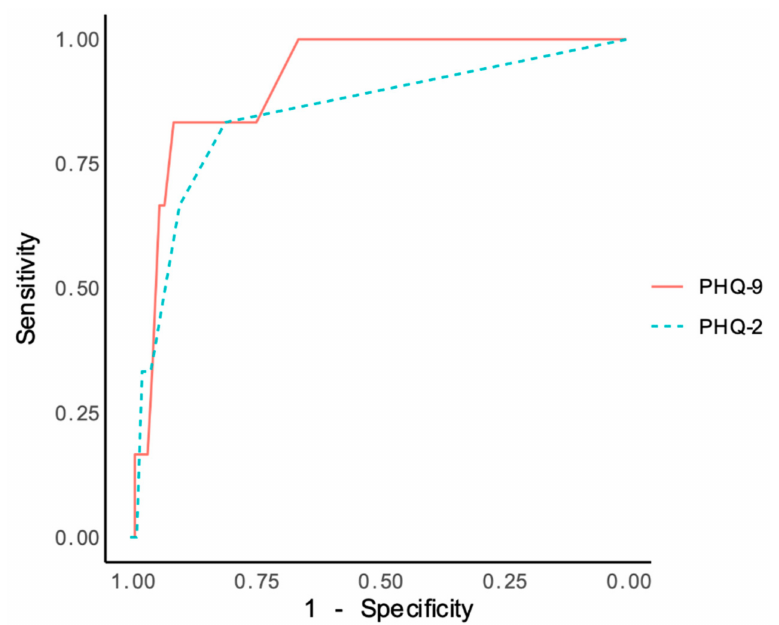
Figure 1. Receptor operating characteristics (ROC) curves of the PHQ-9 and PHQ-2 compared with the Composite International Diagnostic Interview as a reference standard for MDD. Table 3. Performance of PHQ-9 and PHQ-2 cut-off scores in detecting major depressive